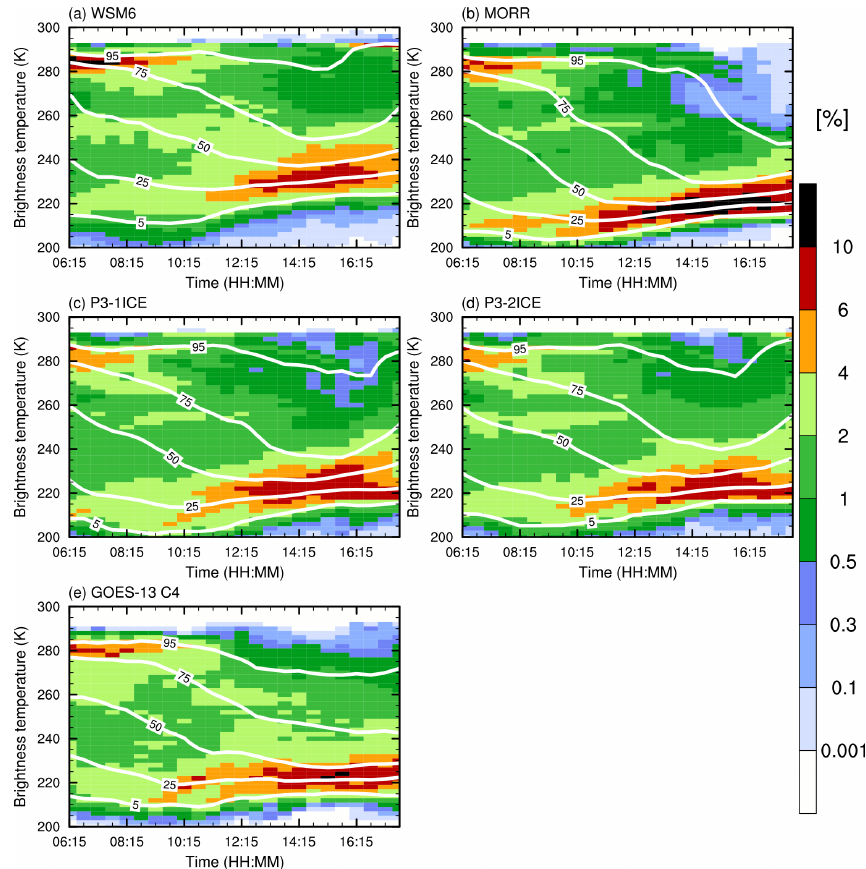
Figure 5. Frequency (%, shaded) of simulated and observed BT from GOES-13 channel 4 from 06:15 to 17:45UTC on 26 May 2015. Contours represent cumulative frequencies 5%, 25%, 50%, 75%, and 95%,